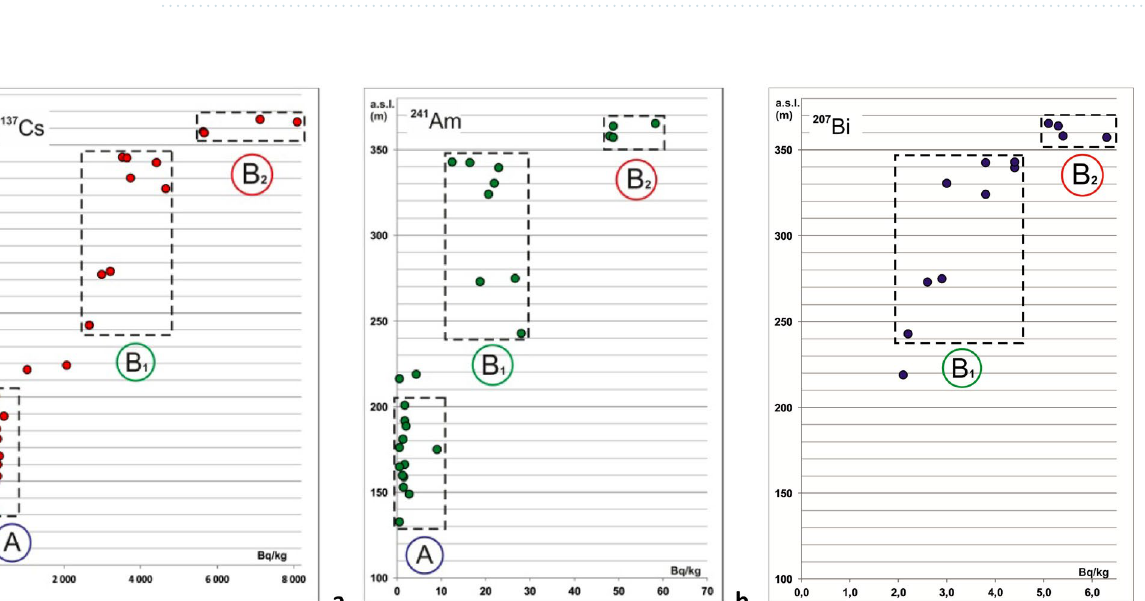
Table 1. Maximum and mean levels of 137 Cs radioactivity (Bq kg −1 ) in Arctic glacier cryoconite.